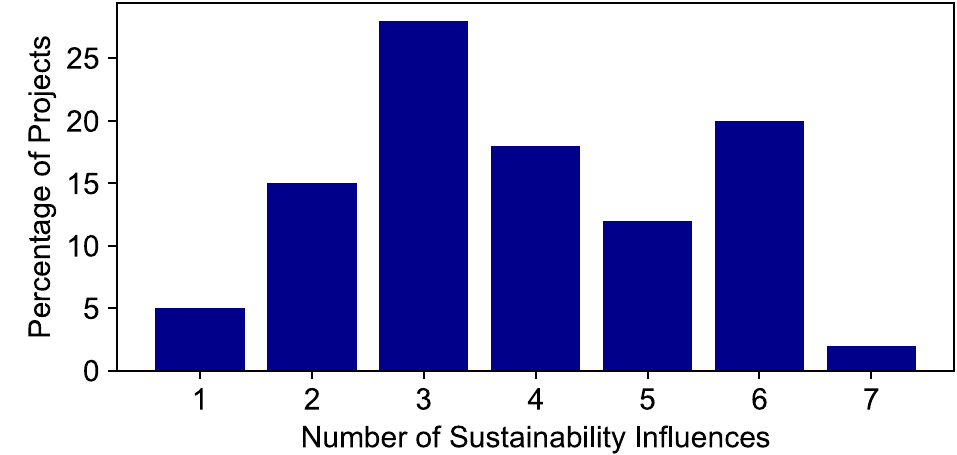
Fig 4. Percentage of projects with a certain number of sustainability